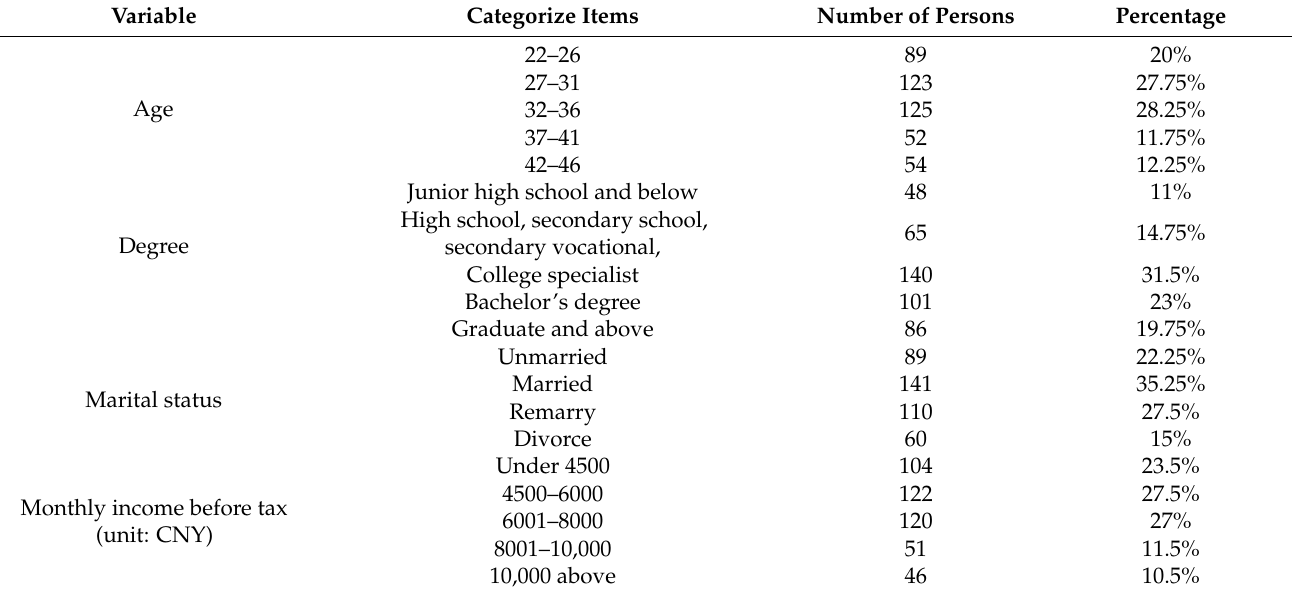
Table 1. Questionnaire for survey respondents’ basic information